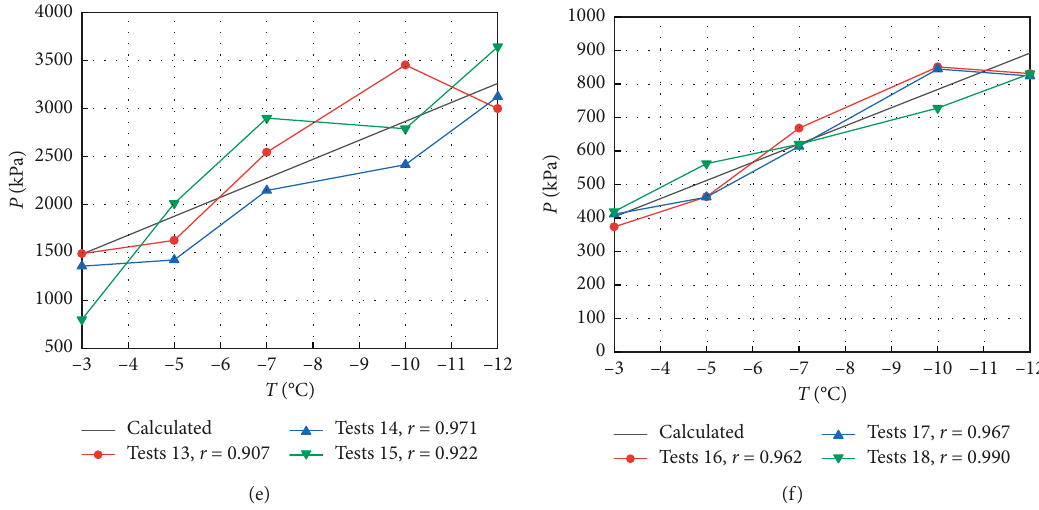
Figure 5: Comparison of the measured values and fitted values for frost-heave force. (a) w � 24%, T � − 7 ° C. (b) w � 26%, T �− 12 ° C. � 1.60g · cm − 3 , T � − 12 ° C. (d) ρ (c) ρ d